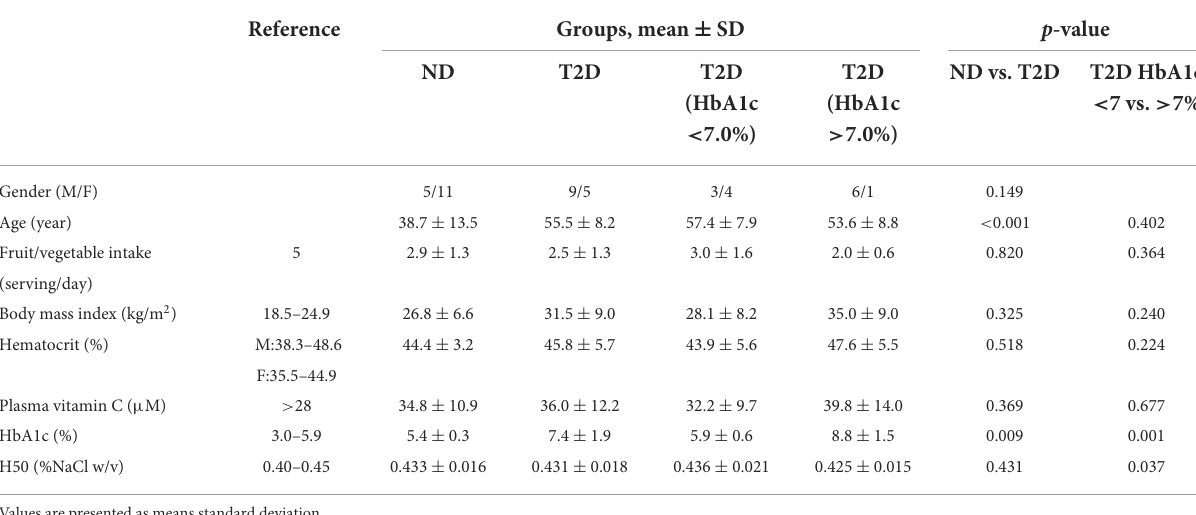
TABLE 1 Comparison of characteristics and biochemical parameters for participant groups.